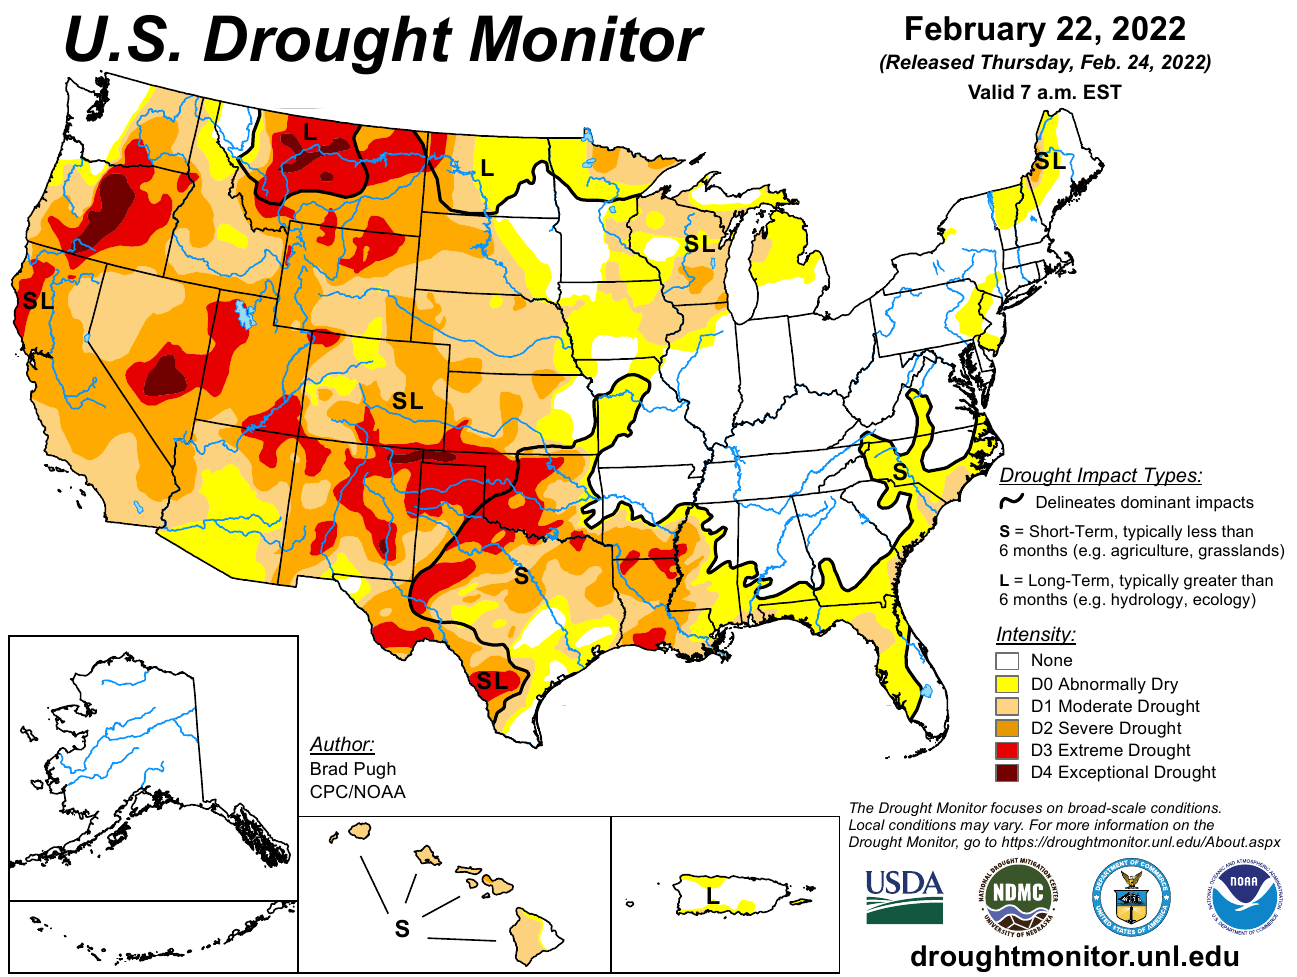
droughtmonitor.unl.edu